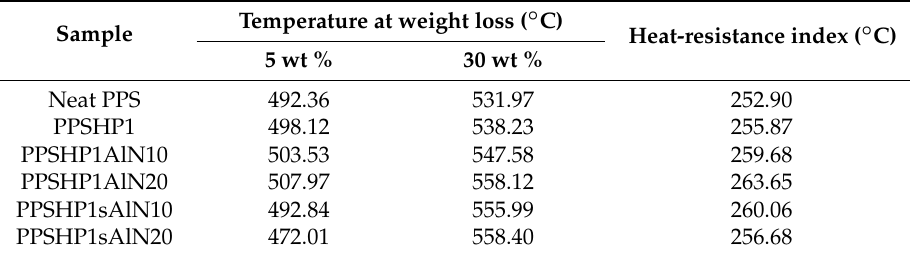
Figure 8. TGA thermogram of the PPS/MWCNTs/AlN composites. Table 3. TGA characteristic thermal data of the PPS/MWCNTs/AlN